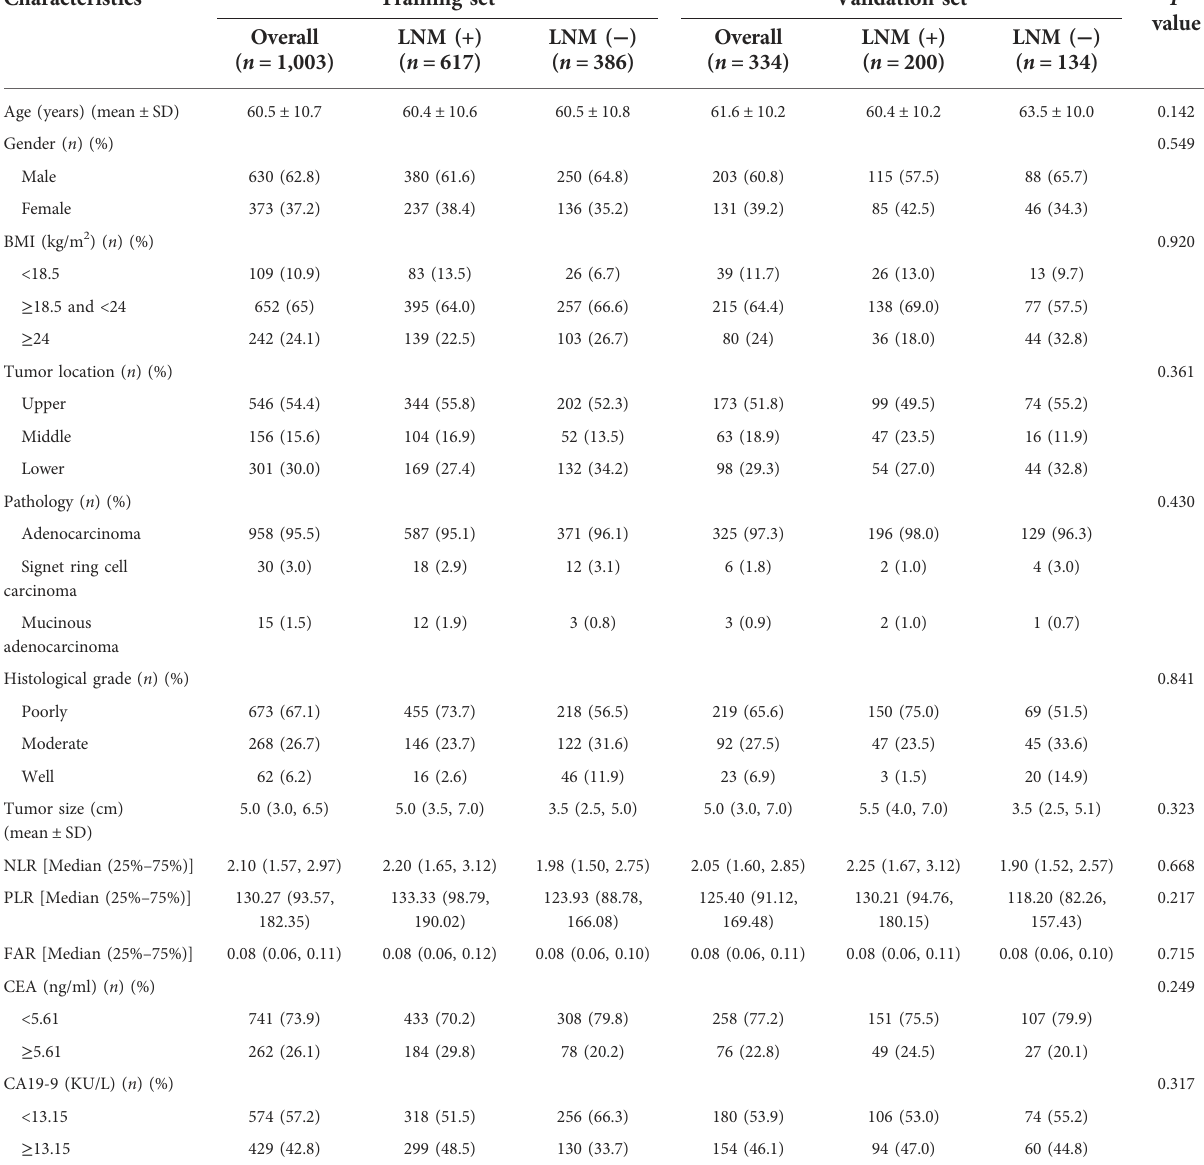
TABLE 1 Baseline and clinical characteristics of patients in training cohort and validation cohort.